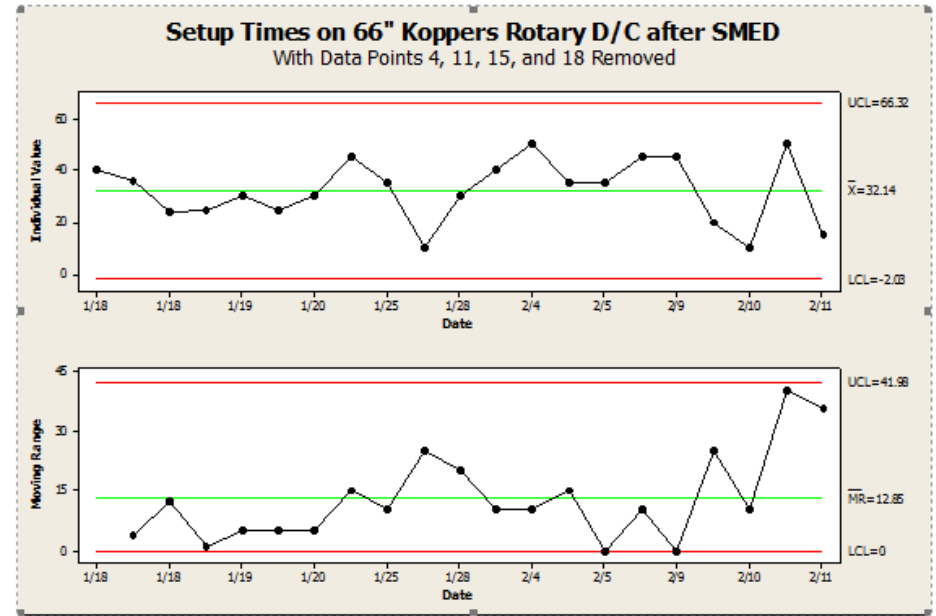
Fig. 3. Setup times during the first 25 setups after SMED with data points 4, 11, 15, and 18 removed.